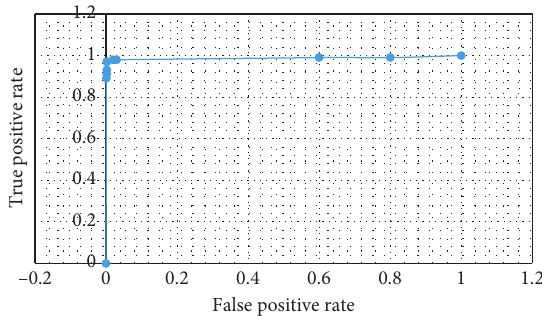
Figure 7: ROC curve for the proposed Table 4: Performance results of the proposed model.